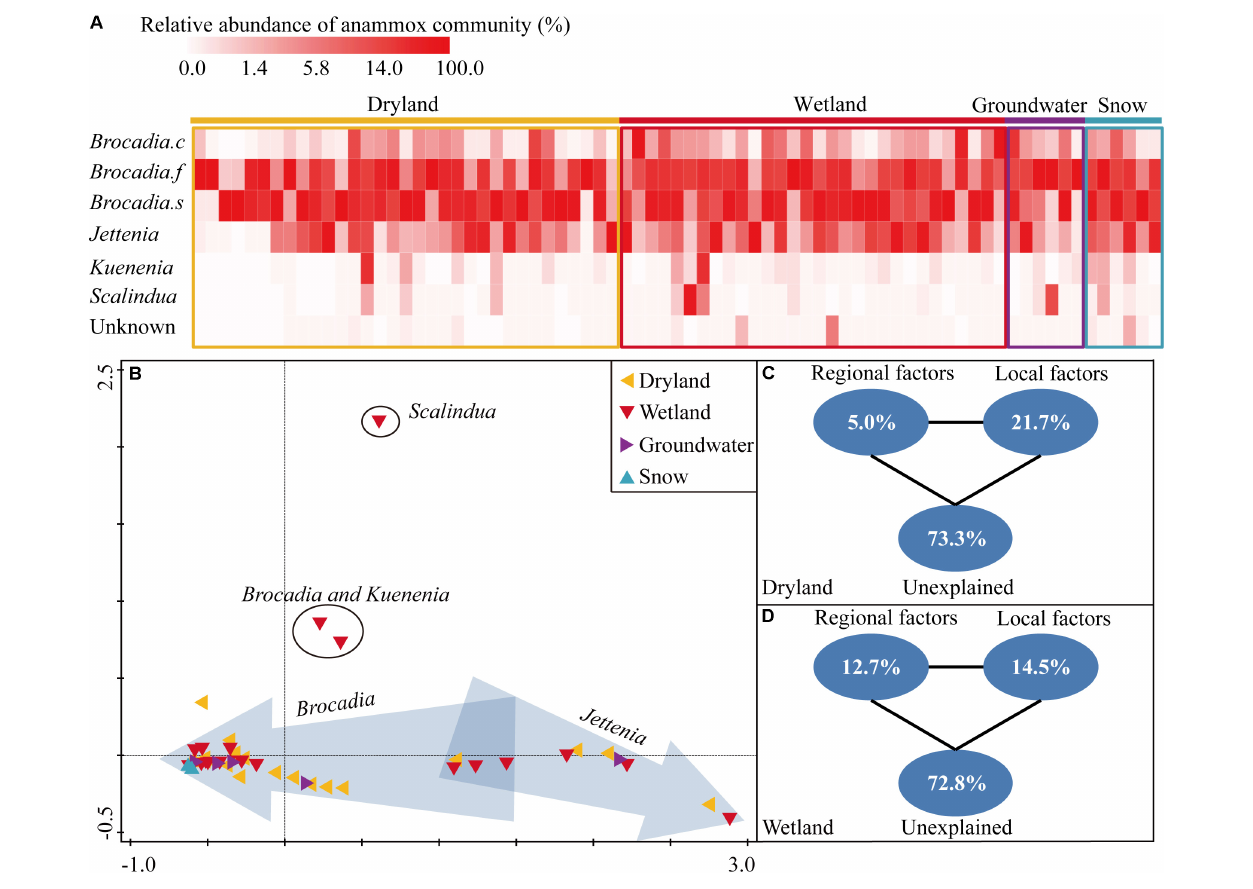
FIGURE 2 | Heatmap showing the relative abundance of each species or genus in each sampling site (A) , the non-metric multidimensional scaling ordination (NMDS) based on Bray-Curtis similarity of anammox bacterial communities at each sampling site. Sites in arrows indicated that the dominant genus was Jettenia or Brocadia (B) , variation partitioning analysis showing the relative influence of environmental factors on the structuring of the anammox bacterial community in drylands (C) and wetlands (D)